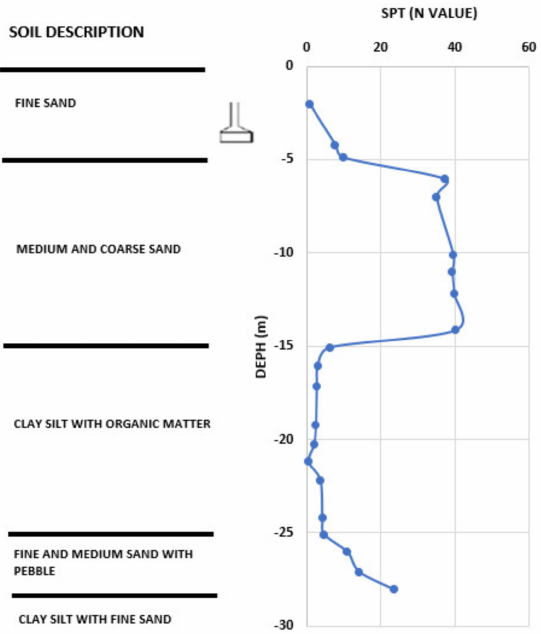
Figure 4. Surveys carried out during the building design phase [38].